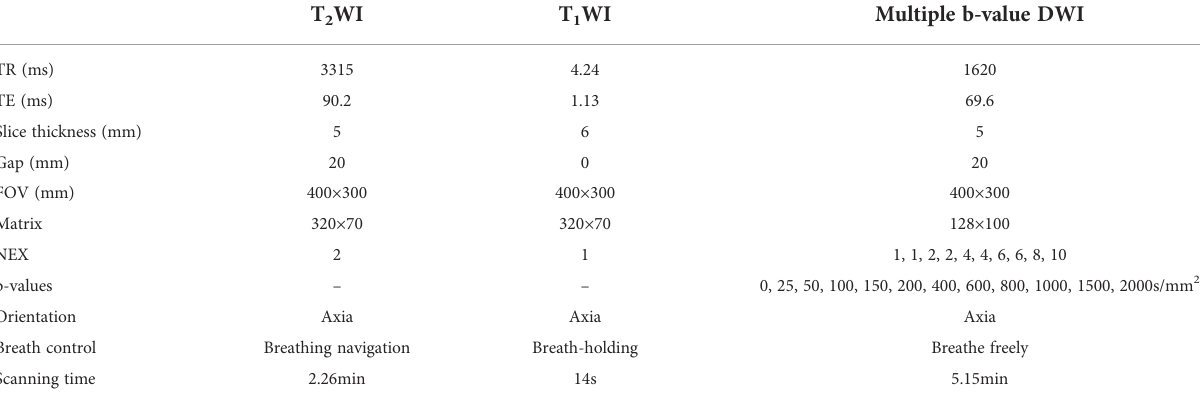
TABLE 1 Scanning parameters of